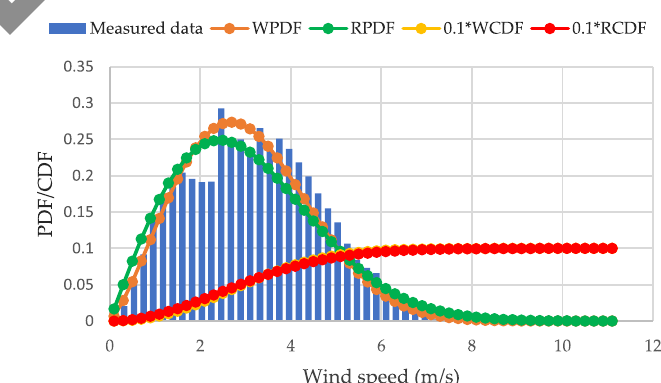
Fig. 9. Wind speed frequency distribution analysis for 2019 – 2020.